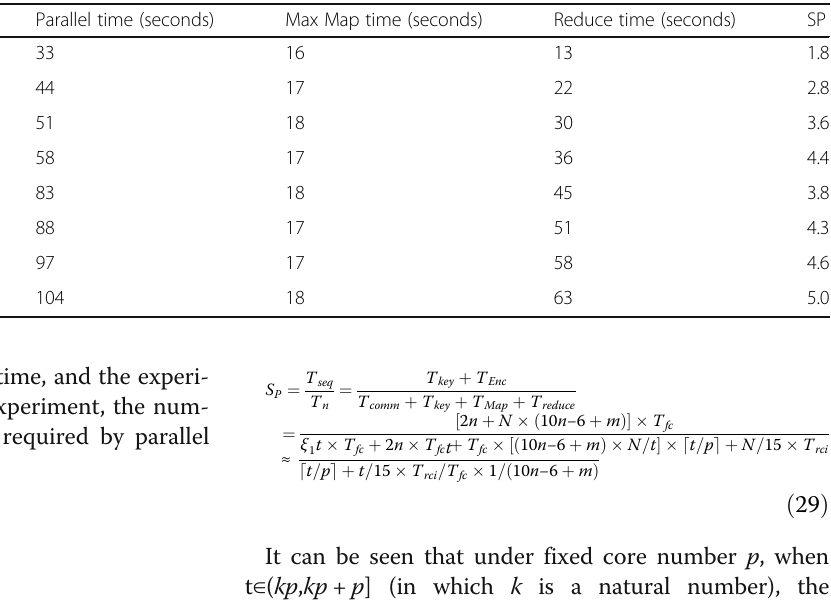
Table 2 The test results of different size file